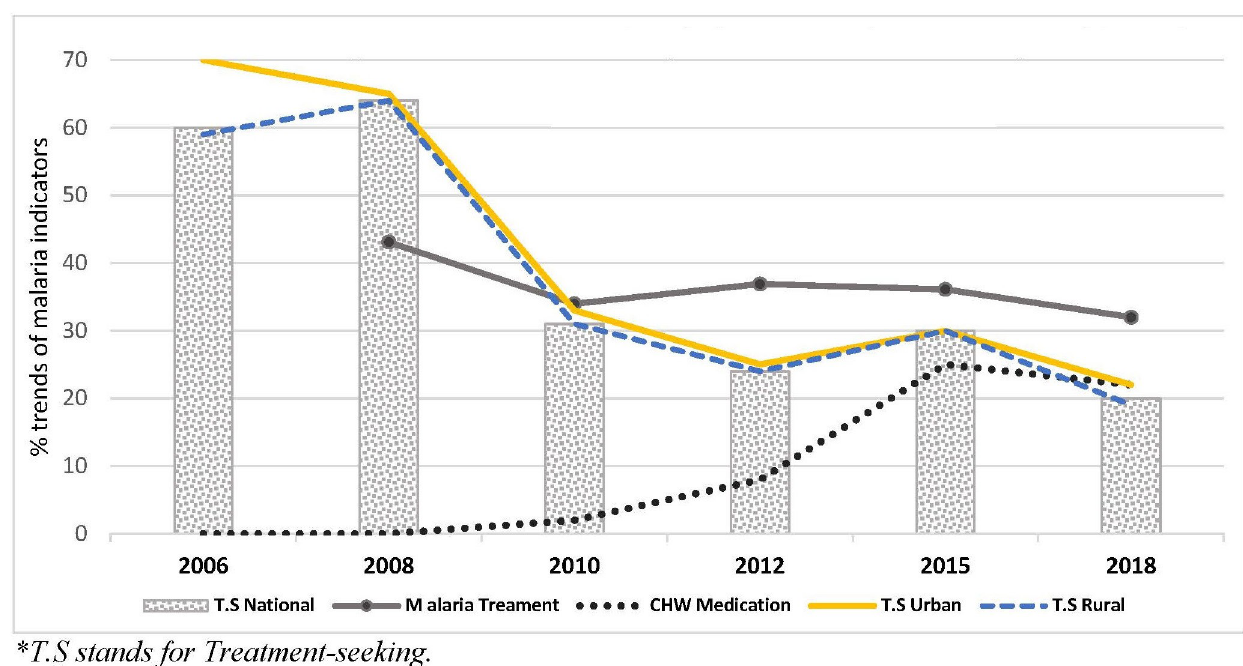
Fig 9. Treatment-Seeking behaviours and Community Health Worker medications in Zambia 2006–2018. � T . S stands for Treatment-seeking . Data source : MIS reports 2006 , 2008 , 2010 , 2015 , & 2018